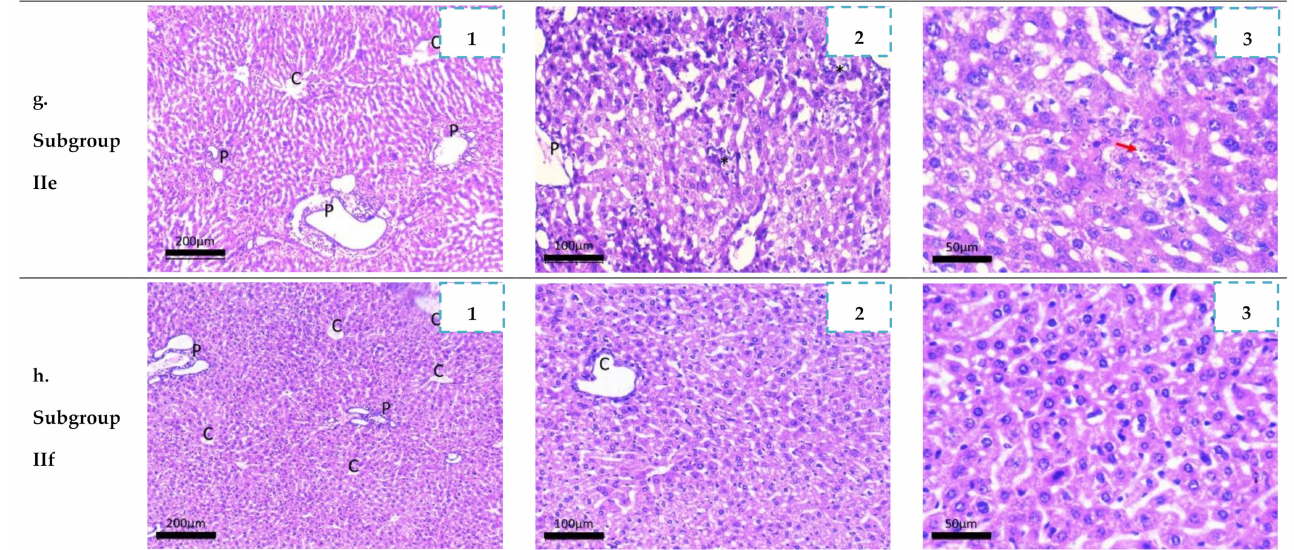
Figure 9. Liver sections of different Toxoplasma -infected subgroups showed: ( a ) Subgroup Ia: ( a1 ) loss of normal lobular architecture of liver (100 × ). ( a2 ) Moderate mononuclear portal inflammation is seen as well as dilated ectactic portal vessels (P). Multiple foci of focal lytic necrosis are seen (asterisk). They are seen as focal collection of lobular lymphocytes around apoptotic hepatocytes (200 × ). ( a3 ) Numerous tachyzoites (red arrows) intra- and extracellular within necrotic foci (400 × ). ( b ) Subgroup Ib: ( b1 ) Restoration of liver architecture ( × 100). ( b2 ) Moderate portal inflammation is still detected (P) and wide areas of vacuolar degenerative changes and microvesicular steatosis (back arrows) (200 × ). ( b3 ) Histologically free hepatocytes with occasional tachyzoites (red arrows). ( c ) Subgroup IIa: ( c1 ) Loss of normal lobular architecture ( × 100). ( c2 ) Portal tracts (P) show mild mononuclear inflammatory infiltrate and ectactic vascular spaces (200 × ). ( c3 ) Necrotic hepatocytes with evident residual tachyzoites (red arrows). ( d ) Subgroup IIb: ( d1 ) Restoration of normal ar- chitecture of liver ( × 100). ( d2 ) Mild portal inflammation is seen (P) with mild residual vascular congestion/ectasia. Only one focus of focal lytic necrosis NPs detected (*) (200 × ). ( d3 ) Normal histol- ogy with no tachyzoites detected in H&E staining (400 × ). ( e ) Subgroup IIc: ( e1 ) Restoration of liver architecture ( × 100). Mild portal inflammation is still detected (P). ( e2 ) Few foci of focal lytic necrosis are seen (*) (200 × ). ( e3 ) Necrotic hepatocytes with evident residual few tachyzoites (red arrows) (400 × ). ( f ) Subgroup IId: ( f1 ) Low power view showing restoration of liver architecture ( × 100). ( f2 ) Mild portal inflammation is still detected (P) with improvement of vascular ectasia/congestion and occasional foci of focal lytic necrosis is seen (asterisk) (200 × ). ( f3 ) Histologically free hepatocytes. No tachyzoites were detected (400 × ). ( g ) Subgroup IIe: ( g1 ) Restoration of liver architecture ( × 100). No portal inflammation (P) is still detected while mild vascular congestion is still seen. ( g2 ) Few foci of focal lytic necrosis are seen (asterisk) (200 × ). ( g3 ) Necrotic hepatocytes with few rare residual tachyzoites (red arrows) (400 × ). ( h ) Subgroup IIf: ( h1 ) Restoration of liver architecture ( × 100). No portal inflammation is still detected (P) or vascular congestion/ectasia. ( h2 ) No focal lytic foci are seen (200 × ). ( h3 ) Histologically normal hepatocytes with no detected tachyzoites (400 ×